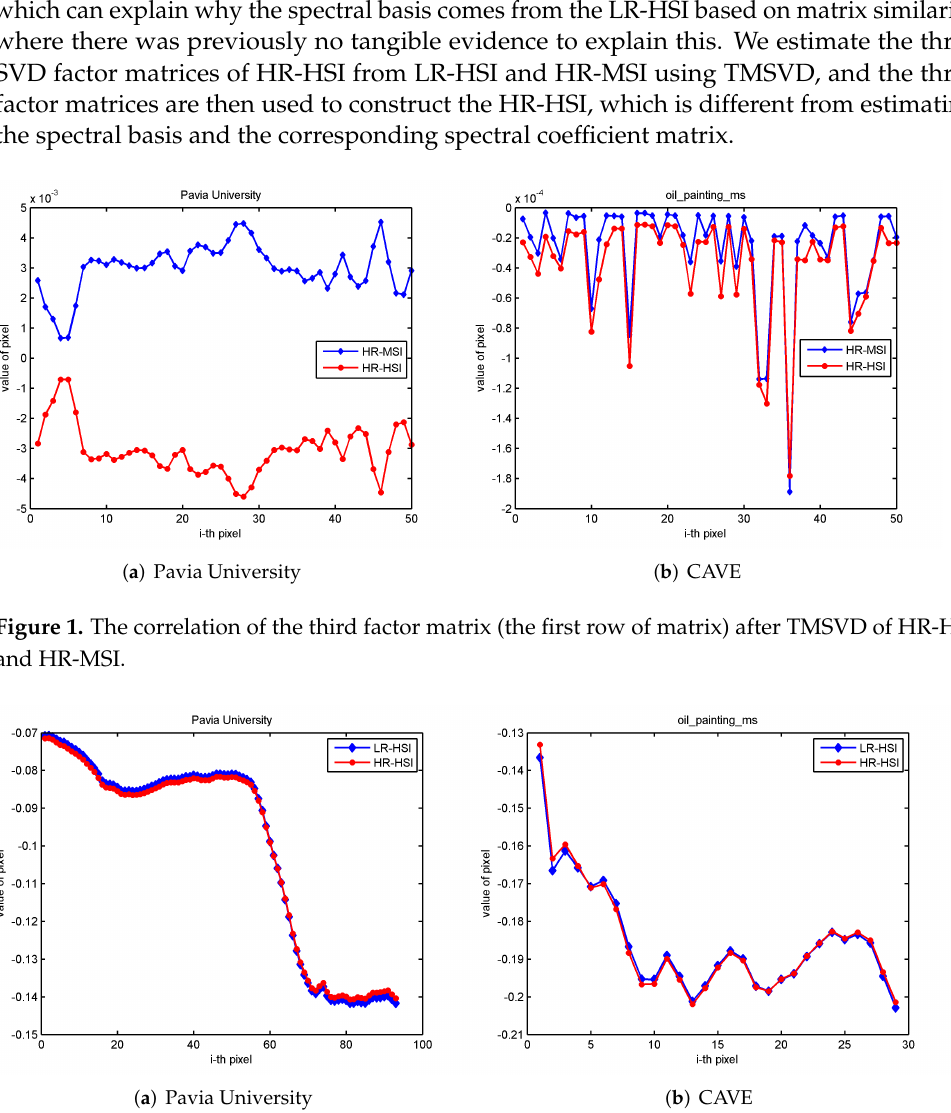
Figure 2. The correlation of the first factor matrix after TMSVD of HR-HSI and